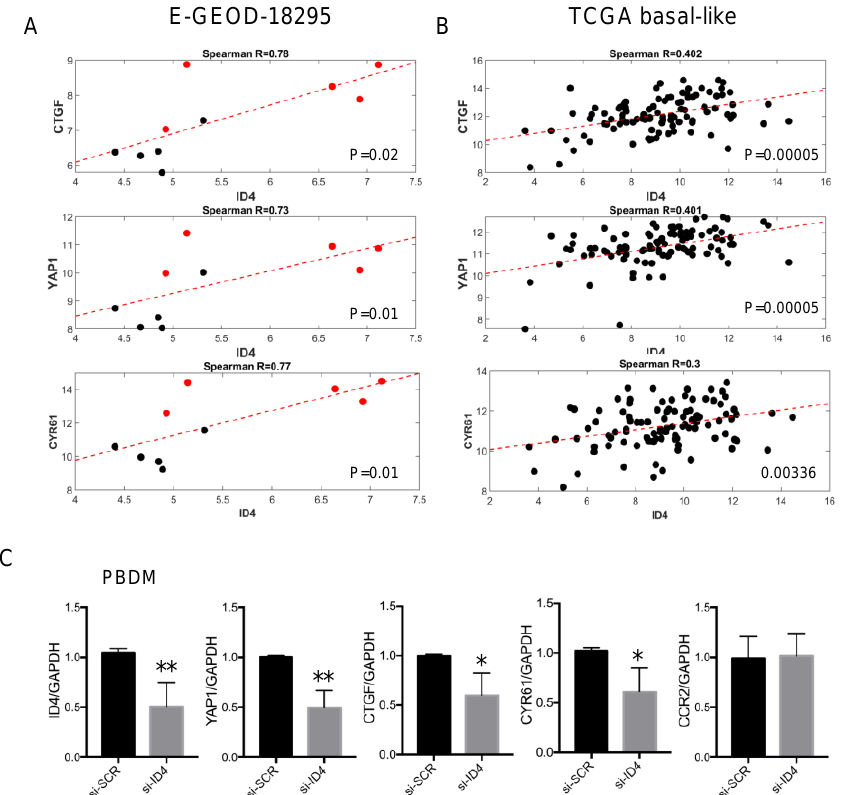
Figure 5. ( A ) Graph showing the correlation (Spearman coefficients) between ID4 and CTGF (upper graph), YAP1 (middle graph) or CYR61 (lower graph) in the geod18295 dataset. Black and red dots refer, respectively, to general and invasive TAMs. ( B ) Graph showing the correlation (Spearman coefficients) between ID4 and CTGF (upper graph), YAP1 (middle graph) or CYR61 (lower graph) in the TCGA dataset, considering the subgroup of basal-like breast tumors with high macrophage infiltration (CD68-high). ( C ) Expression of ID4, YAP1, CTGF, CYR61, and CCR2 in macrophages depleted of ID4 expression by siRNA delivery and in control macrophages (si-SCR). Data obtained from the analysis of macrophages from ≥ 4 donors are presented. *( p < 0.05), **( p < 0.005). p -values were calculated by a paired two-tailed t-test.